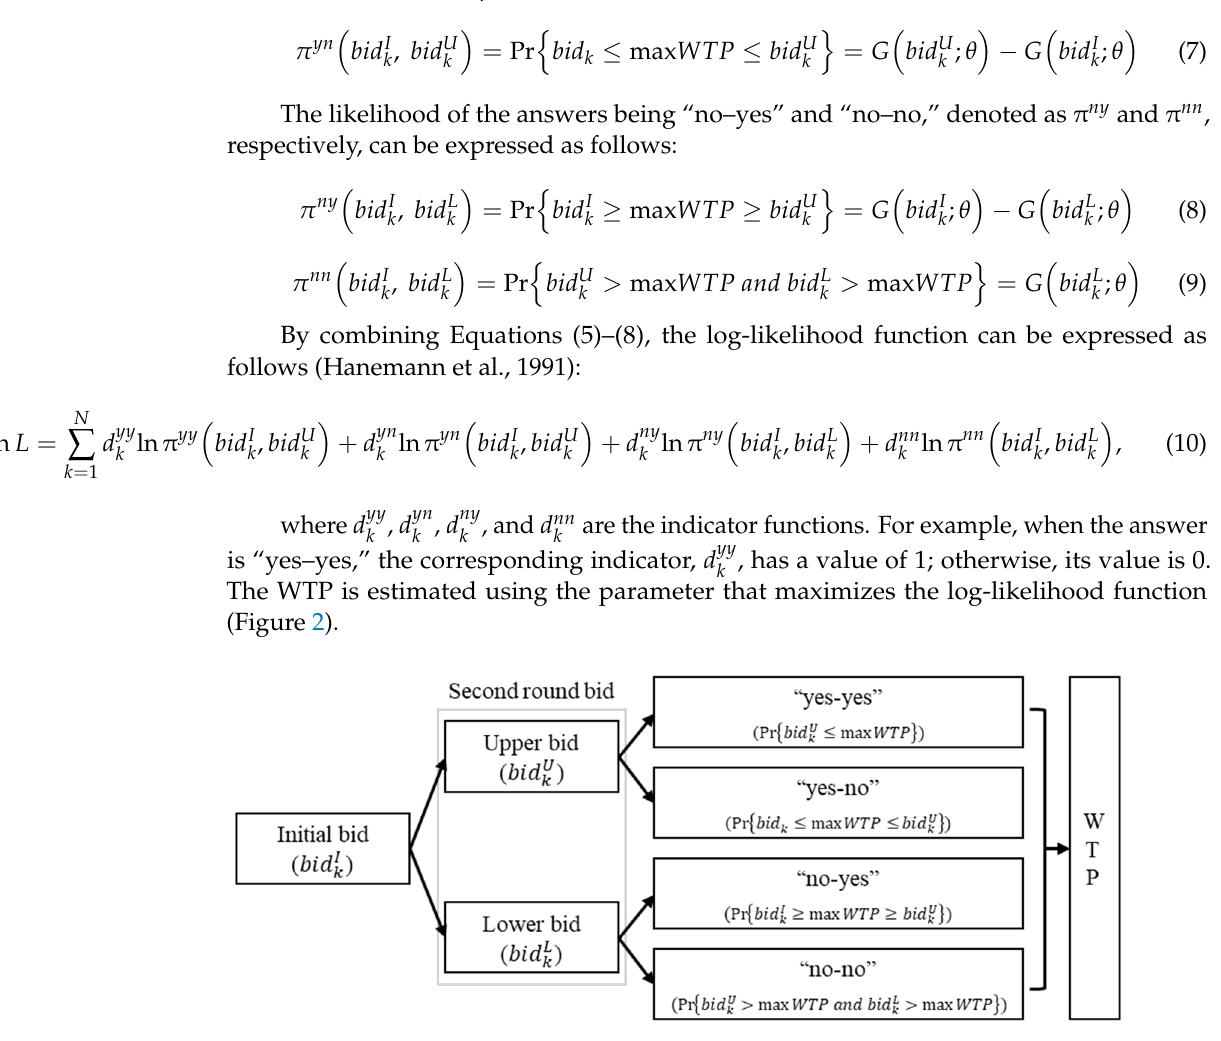
Figure 2. Flowchart of the DBDC model.